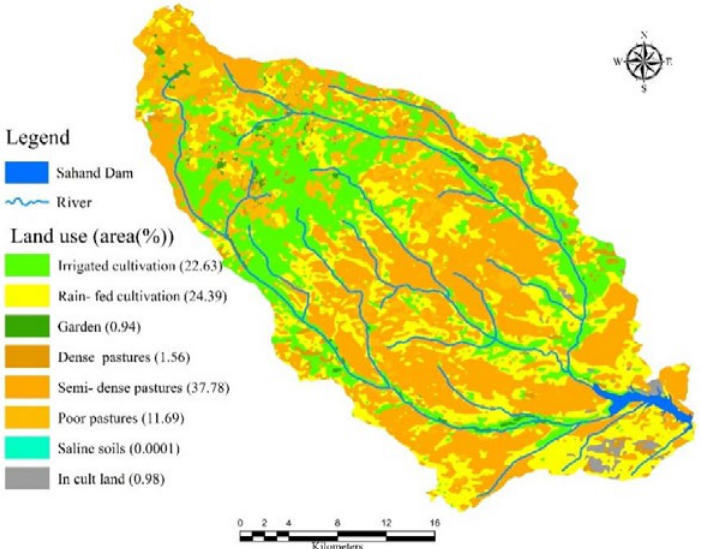
Fig. 2: Land use types (%) in the catchment area of Sahand reservoir